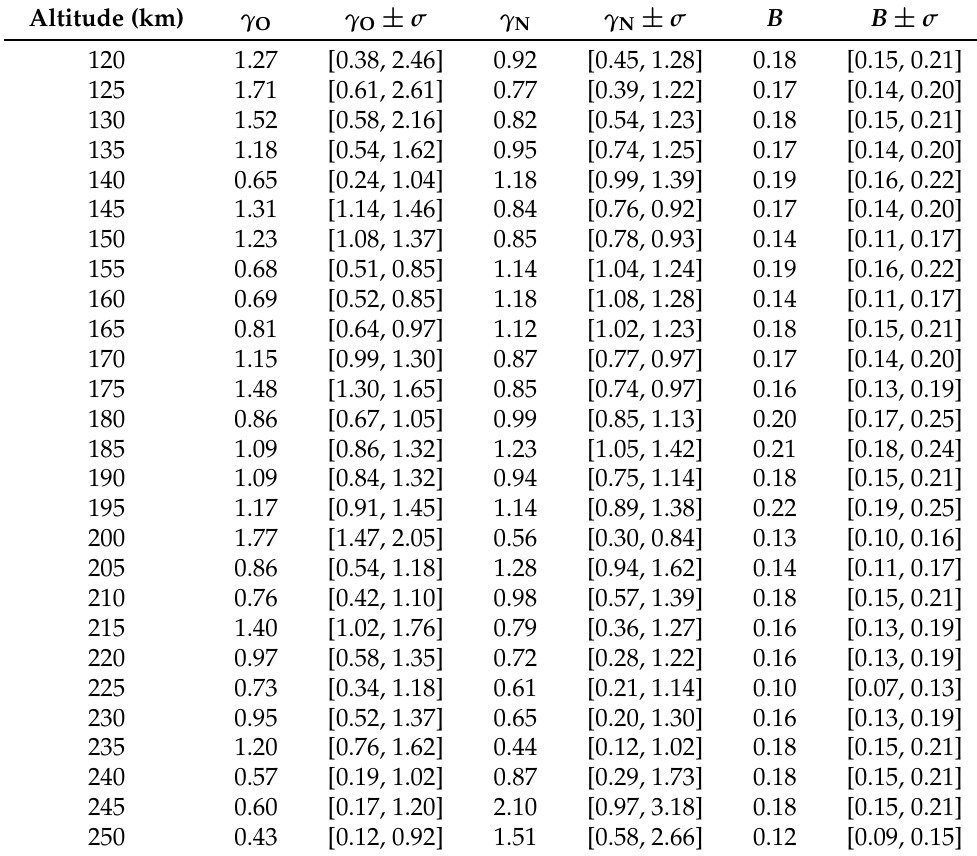
Table 2. The fitting results and confidence intervals of the correction factors γ O , γ N and background B . Altitude (km)